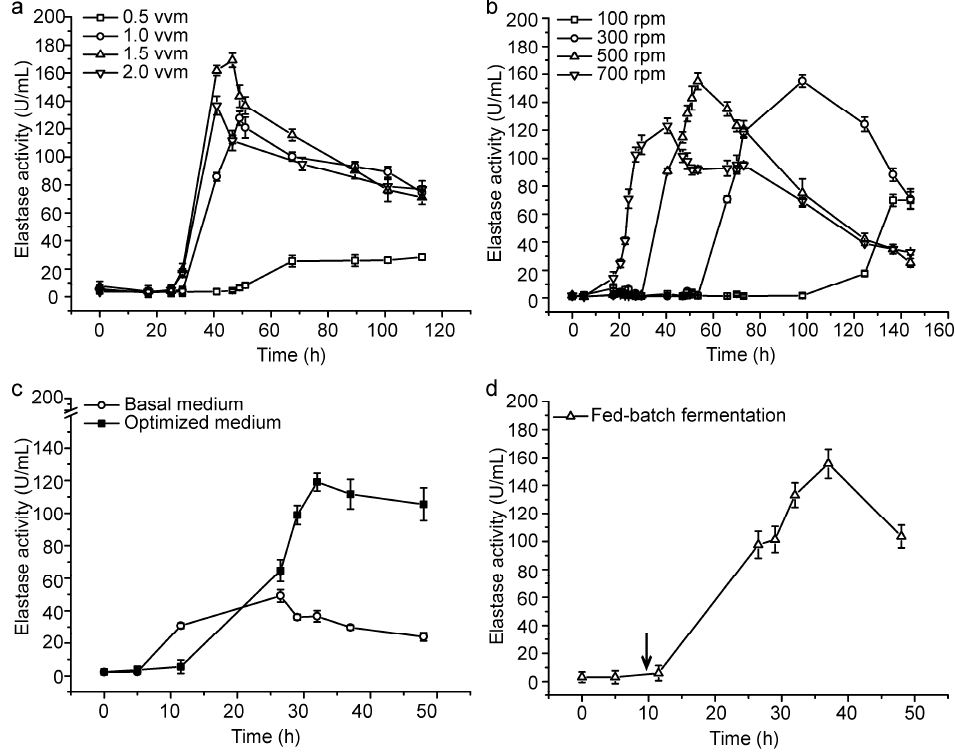
Figure 2. Small-scale fermentation of CF6-2 for pseudoalterin production. ( a , b ) Effects of the aeration rate ( a ) and the rotation speed ( b ) on pseudoalterin production by CF6-2. CF6-2 was cultured in the optimized medium in a mini-in parallel fermenter system; ( c ) The pseudoalterin production by CF6-2 in the optimized medium and in the basal medium in a 5-L fermenter; ( d ) The pseudoalterin production of CF6-2 under the fed-batch fermentation process in a 5-L fermenter. The arrow indicates the time when a 0.5-L feeding medium was supplemented. The graphs show data from treatments performed in triplicate (mean ± S.D.).